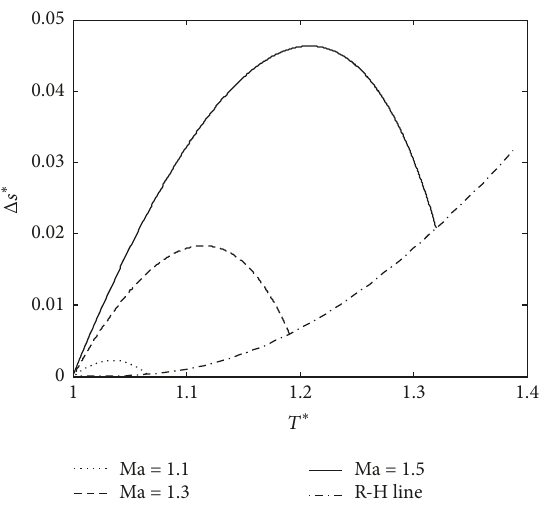
Figure 7: Thickness of transition region and propagation velocity of compressing wave for different piston velocity.